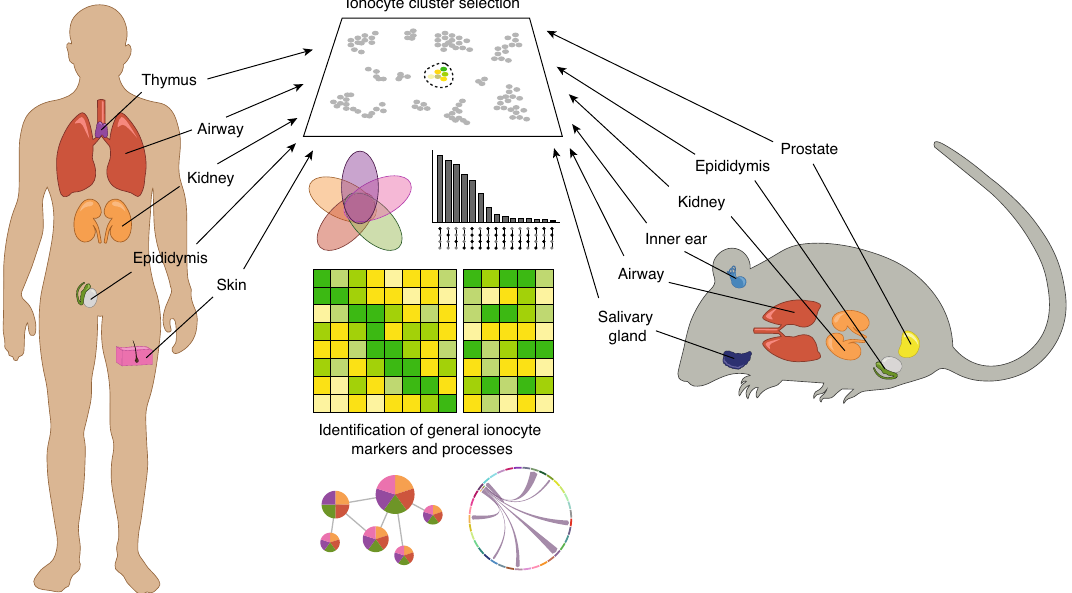
Figure 1. Strategy applied in this study to identify the core ionocyte gene signature in humans and mice.